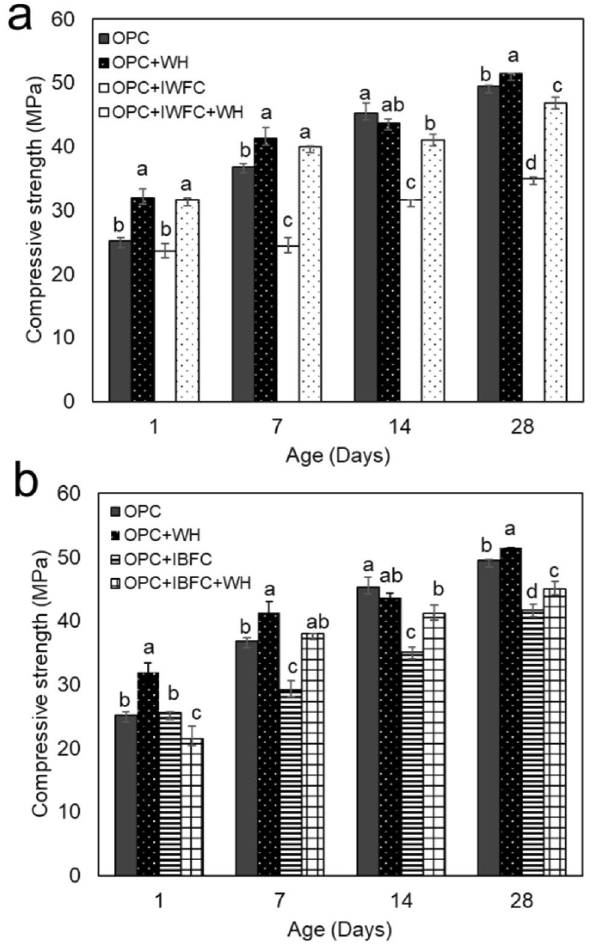
Figure 2. Compressive strength of cementitious composites containing incinerated white filter cake (IWFC) ( a ) and incinerated black filter cake (IBFC) ( b ). Error bars represent standard deviations of the data. Different letters above the bars indicate significant difference at p -value < 0.05 when compared using the Least Significant Difference method (LSD). Data with different letters are significantly